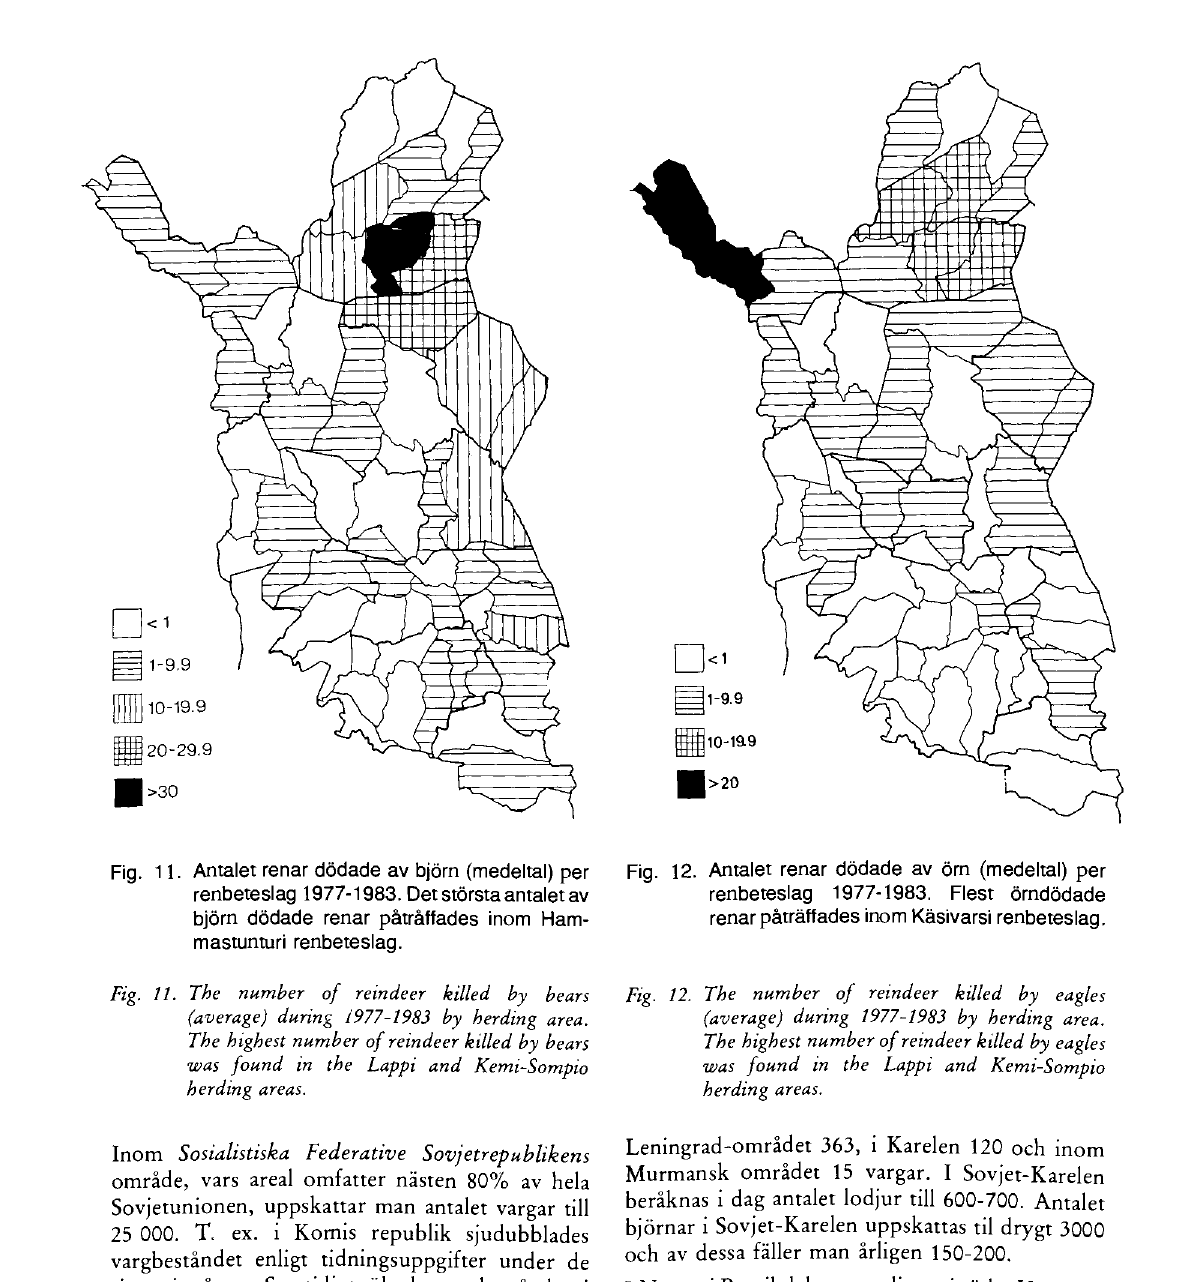
Fig. 11. Antalet renar dödade av björn (medeltal) per renbeteslag 1977-1983. Det största antalet av björn dödade renar påtråffades inom Ham- mastunturi renbeteslag. Fig. 11. The number of reindeer killed by bears (average) during 1977-1983 by herding area. The highest number of reindeer killed by bears was found in the Lappi and Kemi-Sompio herding areas.